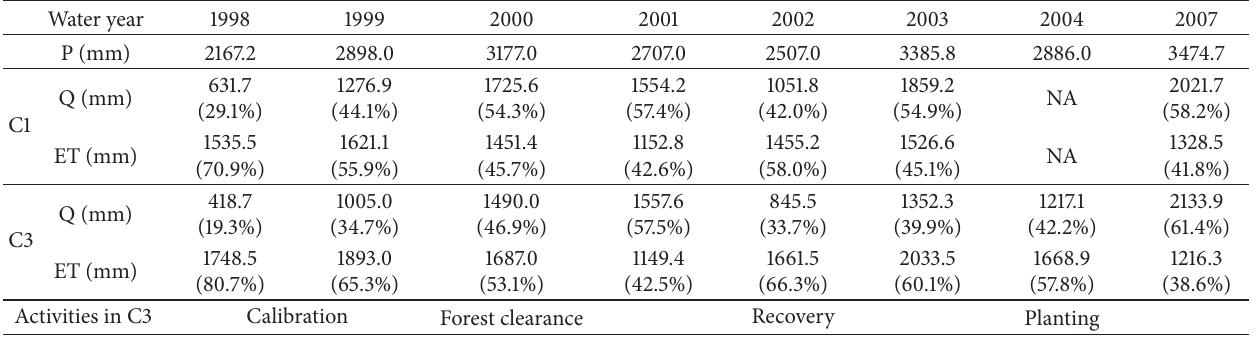
Table 2: Yearly discharges (Q) and annual loss (ET) of C1 and C3 based on water year and by percentages of